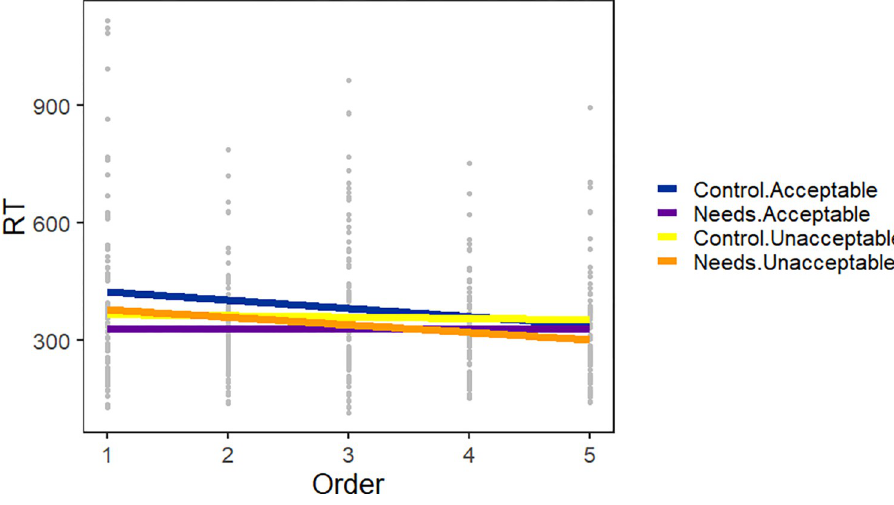
Fig 3. Experiment 1 test block reading times in the spillover (verb + 1) region. Plotted by the order of the five test trials, and the intersection of exposure group (control vs. need(s) ) and regional acceptability (acceptable vs.